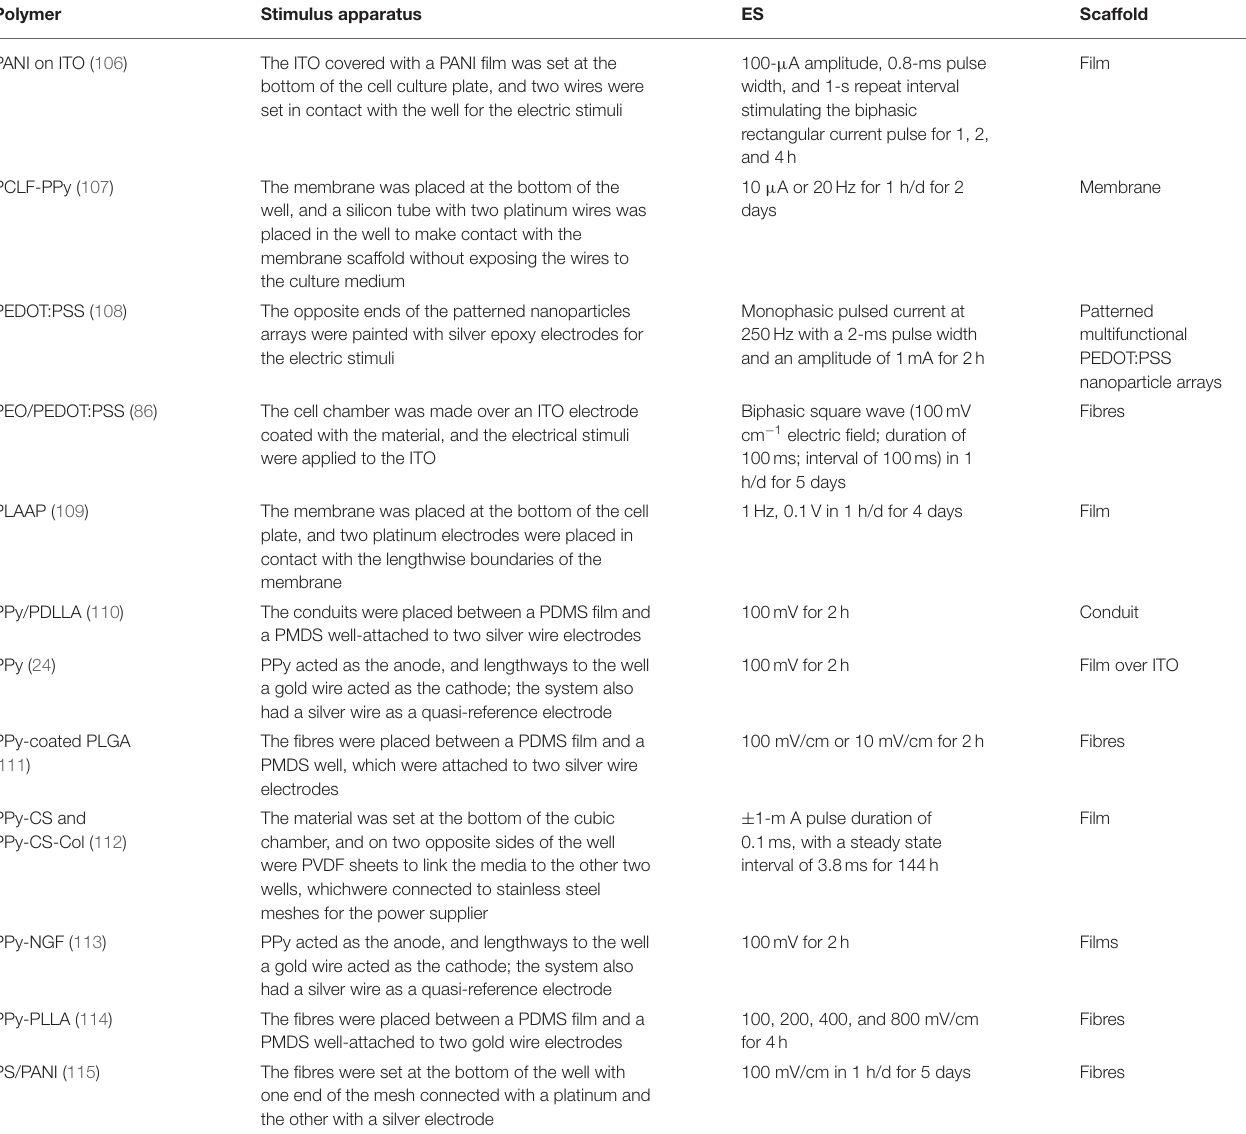
TABLE 3 | Various conditions used in various studies with ES of PC12 cells. Polymer Stimulus